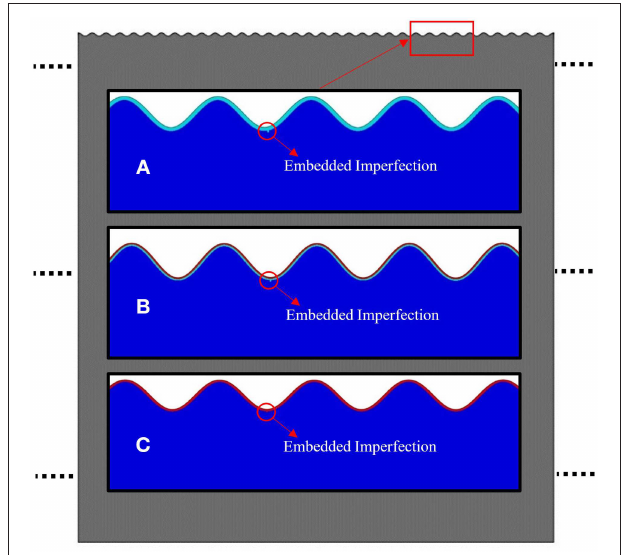
FIGURE 4 | Typical forms of the simulated sinusoidal wrinkles for the cases of (A) 0% P3HT:PCBM, (B) 50% P3HT:PCBM, and (C) 100% P3HT:PCBM. Note that all the images are magnified and scaled for better visualization so the horizontal and vertical length scales are